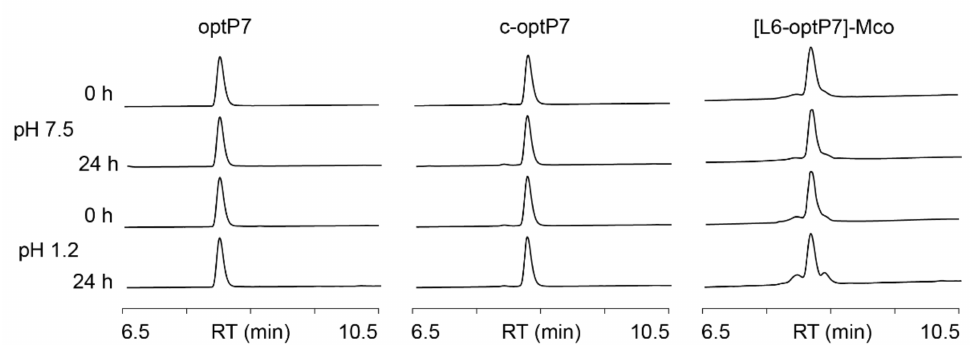
Figure 5. pH stability of the peptides at high and low pH, mimicking conditions present in gastric and intestinal fluids. RT = retention